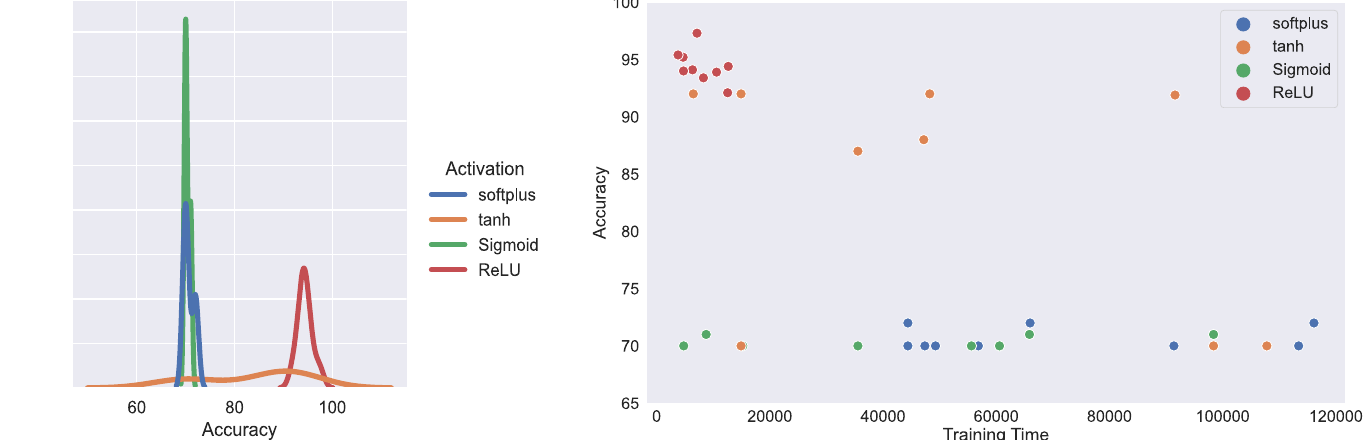
Figure 9. Activation function effect on training time and accuracy when fine-tuning BERT with different number of convolution and dense